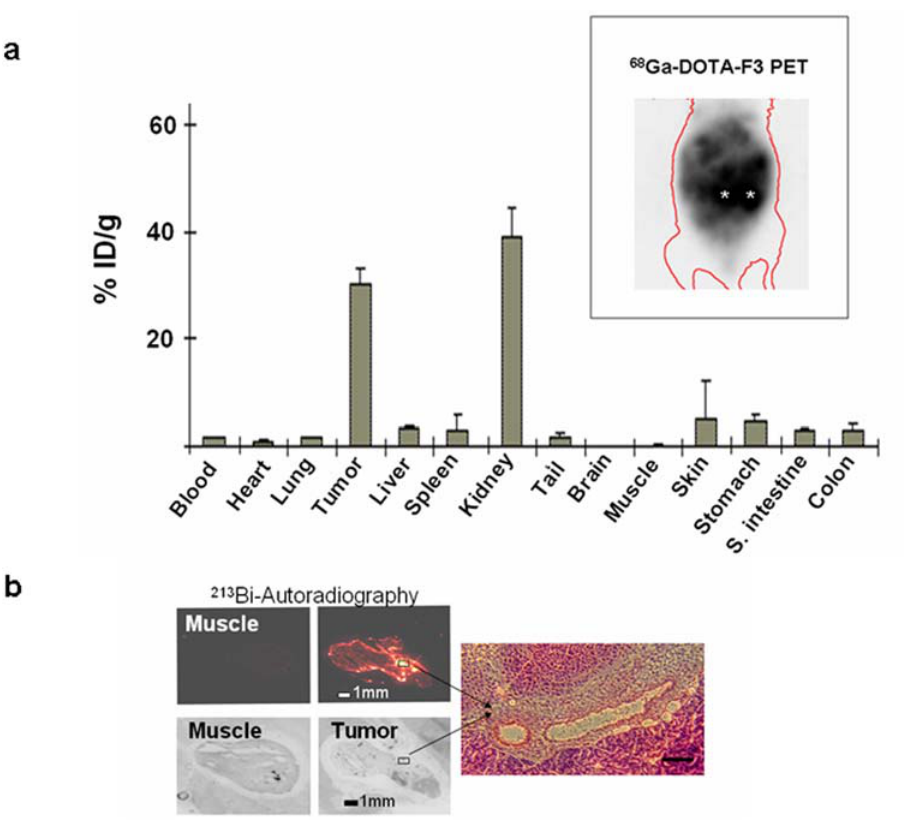
Figure 3. (a) Biodistribution of 213 Bi-DTPA-[F3] 2 . 3.7 MBq of 213 Bi-DTPA-[F3] 2 were injected i.p. into mice bearing intra-peritoneal MDA-MB-435 xenograft tumors. After 45 minutes the 213 Bi-DTPA-[F3] 2 activity present in individual organs, the tumors and the blood was measured. Values represent the percentage of the injected dose/g tissue (%ID/g) 6 SEM. The inset depicts a mouse with peritoneal carcinomatosis imaged with 68 Ga- DOTA-F3-PET. The asterics (*) indicates the location of the kidneys. b) Autoradiography studies were performed using histological sections of MDA- MB-435 xenograft tumors or muscle tissue. 213 Bi-DTPA-[F3] 2 was found in tumors 45 minutes after i. p. injection. 213 Bi-DTPA-[F3] 2 was found in the periphery of the tumor as well as in spots within the tumor tissue. H&E-staining and microscopy (100fold magnification) of the sections revealed that the intra-tumoral accumulation of 213 Bi-DTPA-[F3] 2 occurs in the perivascular region. The H&E-stained picture represents the area within the white box in the autoradiography picture. Negligible activities were found in autoradiography pictures of control organs such as muscle.